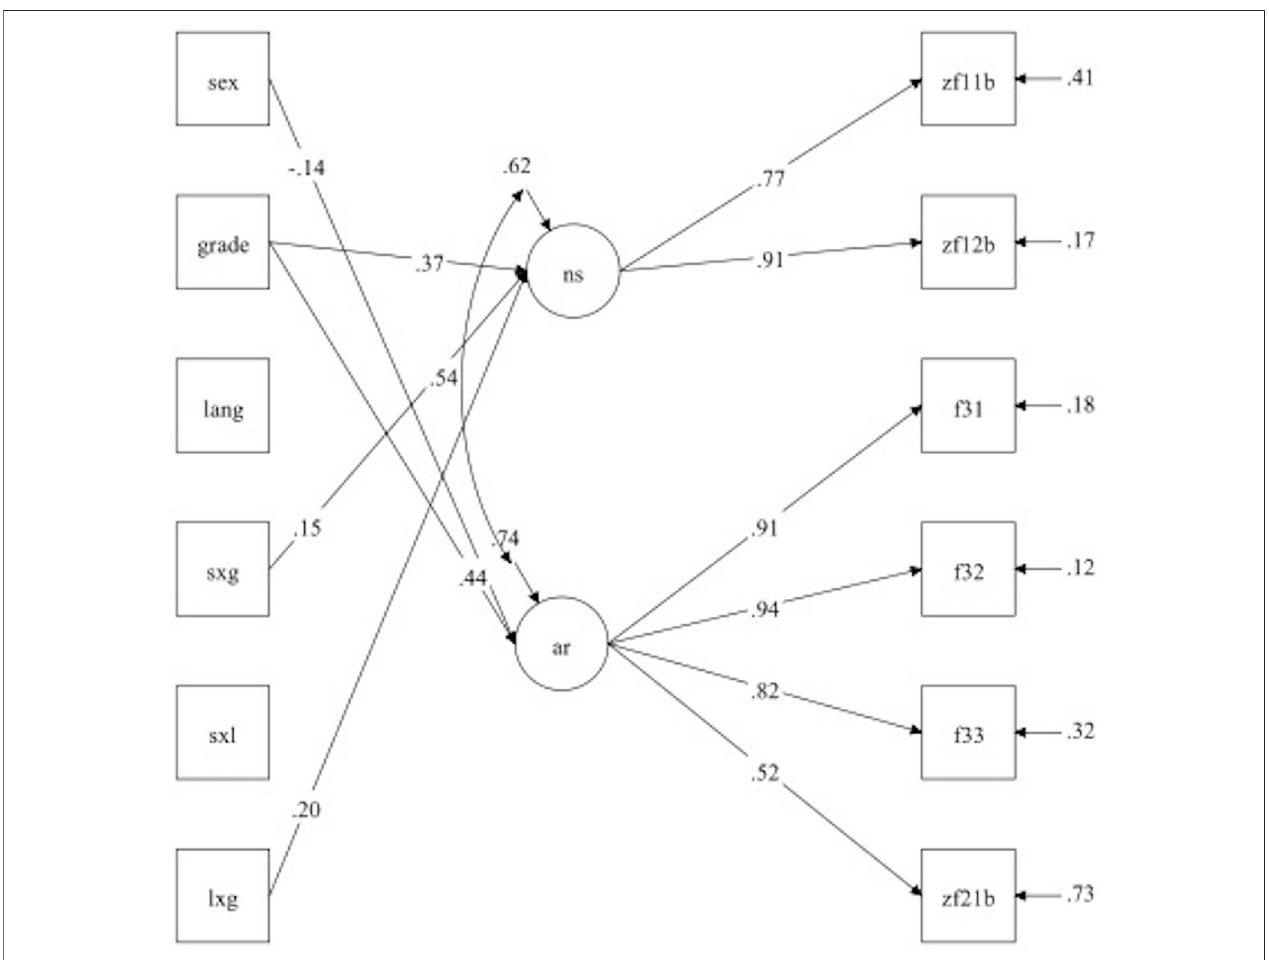
FIGURE2 | Predicting number processing and arithmetic skillswith gender, languagegroup, and grade level.Note. ns (cid:1) number processing; ar (cid:1) arithmetic skills; sex (cid:1) gender; grade (cid:1) grade level; lang (cid:1) language group; sxg (cid:1) sex x grade level; sxl (cid:1) sex x language group; lxg (cid:1) language group x grade level; zf11b (cid:1) number comparison; zf12b (cid:1) dot enumeration; f31 (cid:1) single-digit addition; f32 (cid:1) single-digit subtraction; f33 (cid:1) multi-digt addition and subtraction; zf21b (cid:1) arithmetic